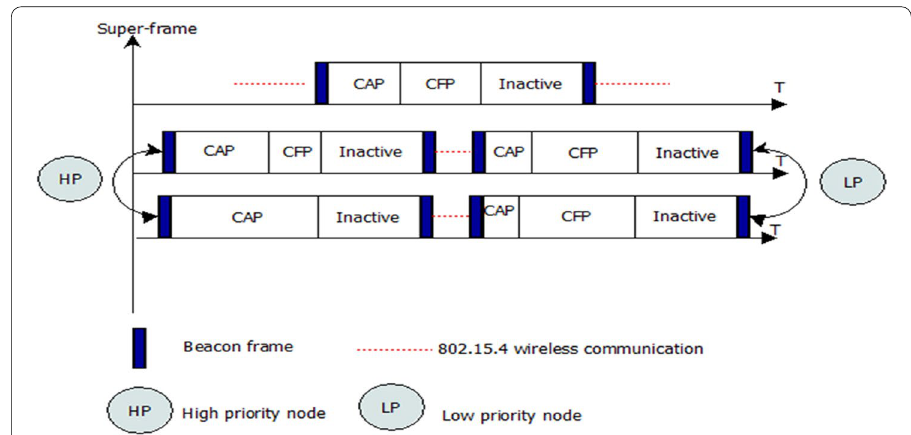
Fig. 3 Set of super-frames using our hybrid scheme